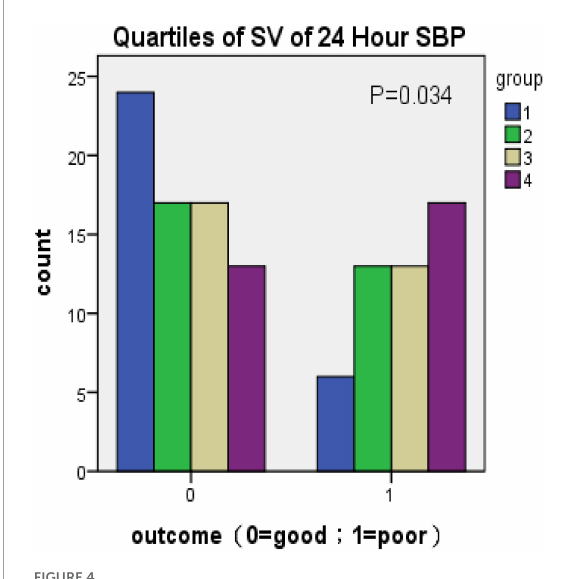
FIGURE3 Quartiles of SD of 1-h SBP (outcome: 0 = good; 1 = poor).